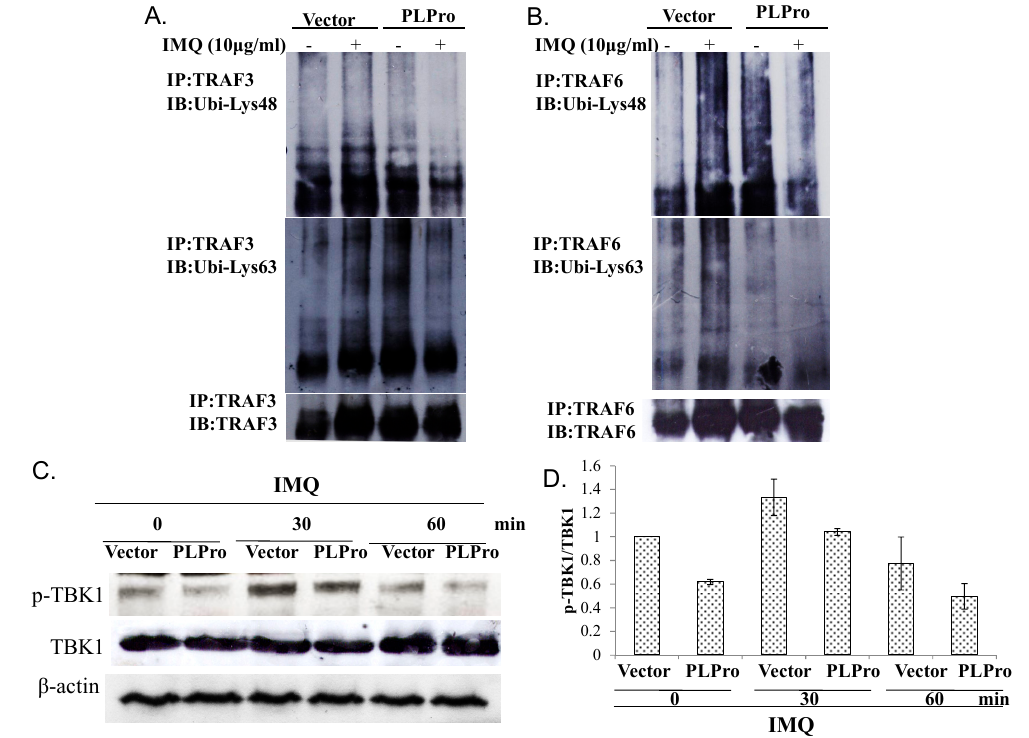
Figure 5. Detecting the Lys48- and Lys63-linked ubiquitination of TRAF3 and TRAF6 measured by the immunoprecipitation assay. Vector control and PLPro-expressing cells were treated with(out) IMQ for 1 day; cell lysates were immunoprecipitated with anti-TRAF3 ( A ) or anti-TRAF6 ( B ) followed by Western blotting probed with either anti-Lys48 ubiquitin or anti-Lys63 ubiquitin antibodies. Phospho-TBK1 levels were detected by Western blot ( C ). The relative band intensity of phospho-TBK1 was normalized by TBK1, compared to the mock vector control cells, and quantified using ImageJ based on triplicate replicates of each experiment ( D ).